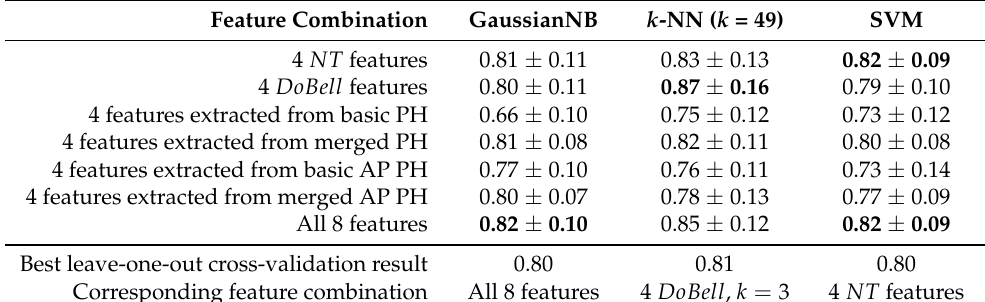
Table 1. The mean and standard deviation values of the three classifiers’ ten-fold cross-validation accuracies applying different combinations of features. The bolded results indicate the optimal perfor- mance of each classifier. The last two rows give the best leave-one-out cross-validation accuracies and their corresponding feature combinations as references. PH: pitch histogram; AP: anhemitonic penta-